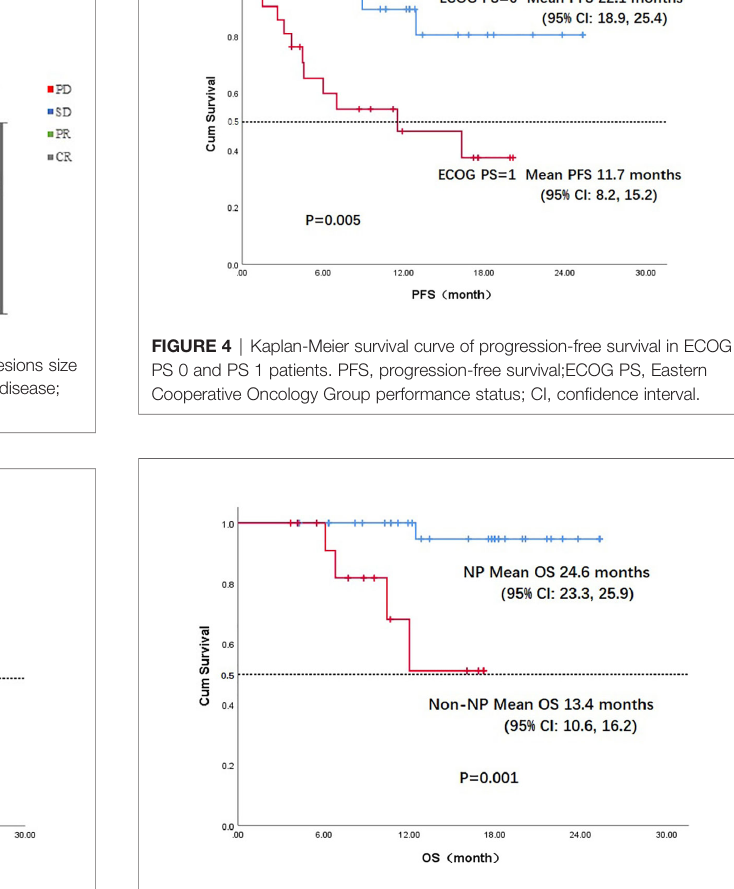
FIGURE 5 | Kaplan-Meier survival curve of overall survival in NP and non-NP patients. OS, overall survival;NP, nasopharyngeal cancer; CI, con fi dence